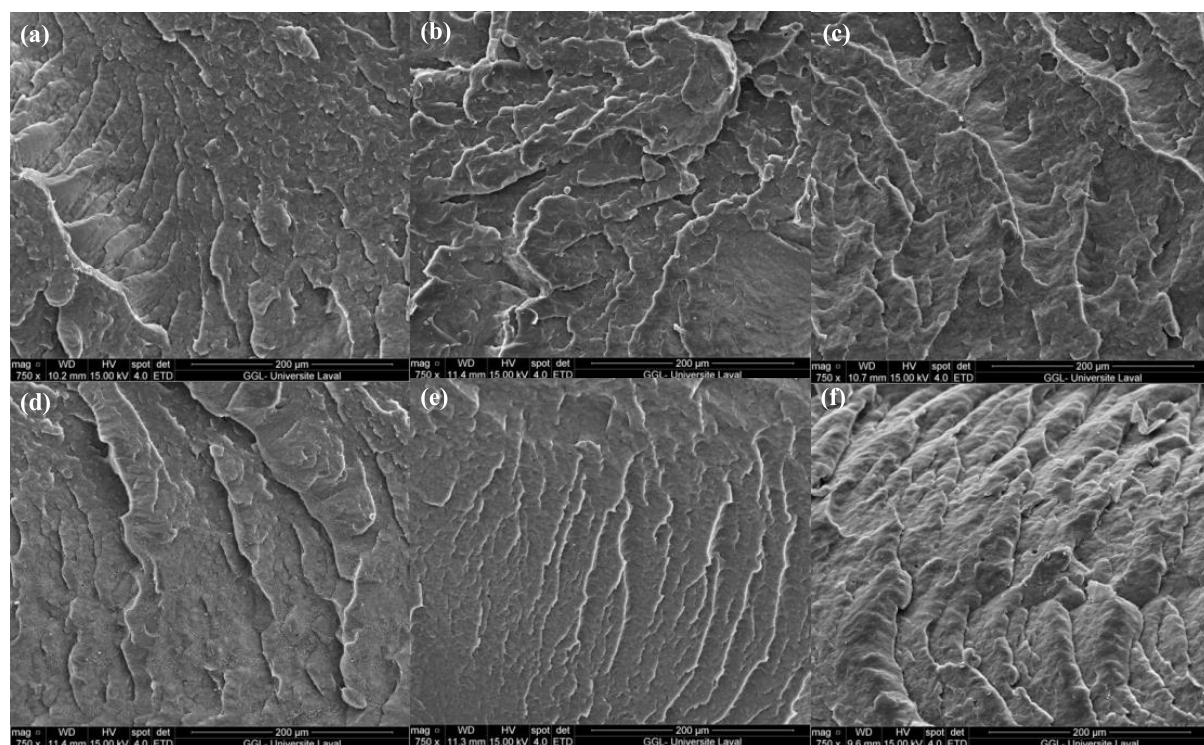
Figure 1. SEM micrographs of the morphology (×750) of: ( a , d ) vHDPE, ( b , e ) 60 wt.% vHDPE + 40 wt.% rHDPE and ( c , f ) rHDPE. The top row ( a – c ) is powder mixing (PM), and the bottom row ( d – f ) is extrusion mixing (EM).